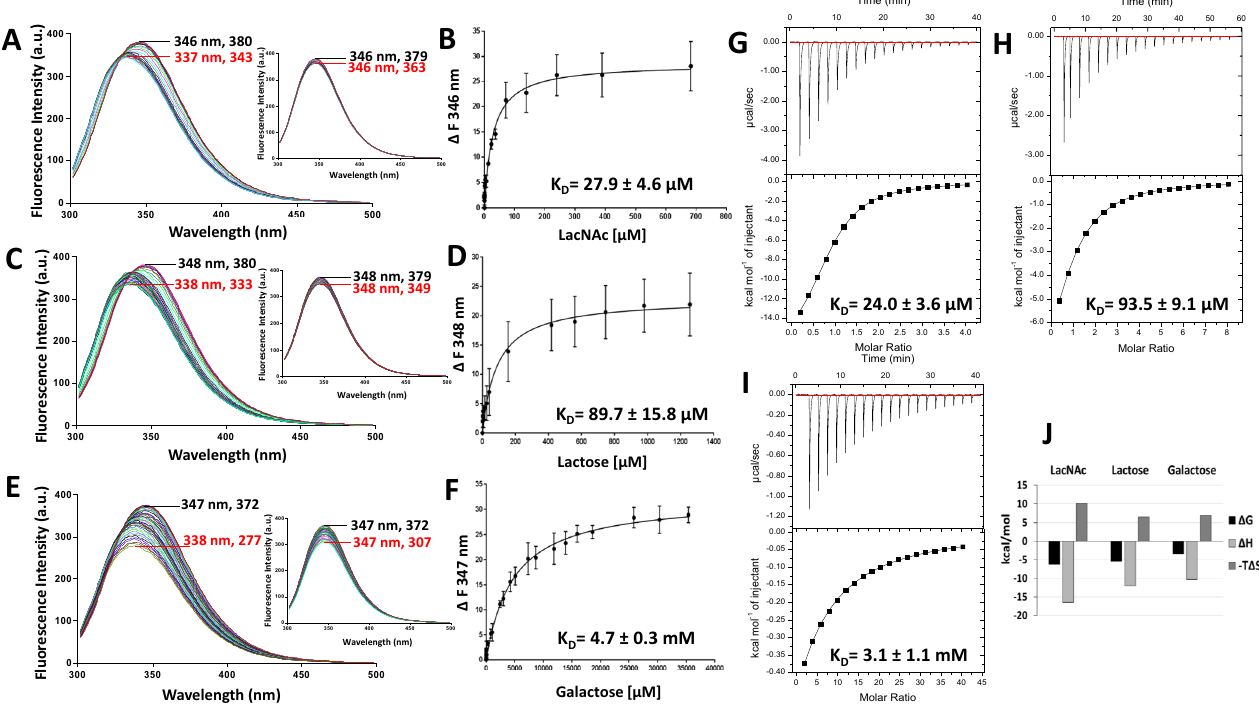
Figure 3. Determination of galectin-3-ligand interactions by TFS and ITC. Galectin-3 (10 µ M) florescence intensity with increased concentrations of LacNAc ( A ) lactose ( C ) and galactose ( E ) were recorded by fluorescence spectroscopy. Numbers indicate the maximum fluorescence wavelength and corresponding fluorescence intensity for the first (no ligand/buffer titration, black) and last (red) titration traces. Inserts in each panel show buffer control titrations. Ligand concentrations vs changes in fluorescence intensity at single wavelength were plotted and analysed using One site- Specific binding model to obtain the galectin-3 binding affinities to LacNAc ( B ) lactose ( D ) and galactose ( F ). Heat changes for titration of galectin-3 (100 µ M) with 2 mM LacNAc ( G ), 4 mM lactose ( H ) and 20 mM galactose ( I ) were recorded by ITC (upper panels) with data fit to One set of sites interaction model (bottom panels). Data were plotted as means ± SEM from three independent experiments for each assessment. Panel (J) shows thermodynamic profiles with enthalpy ( ∆ H), entropy ( ∆ S) and Gibbs free energy ( ∆ G) changes associated with galectin-3 binding to LacNAc, lactose and